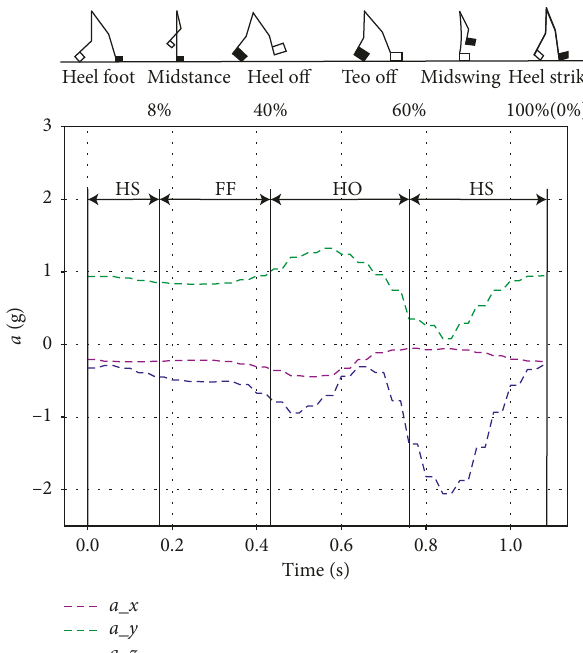
Figure 4: Phase division diagram of gait. Green curve represents the acquired foot acceleration data, brown curve represents the acquired calf acceleration data, and blue curve represents the collected thigh acceleration data.